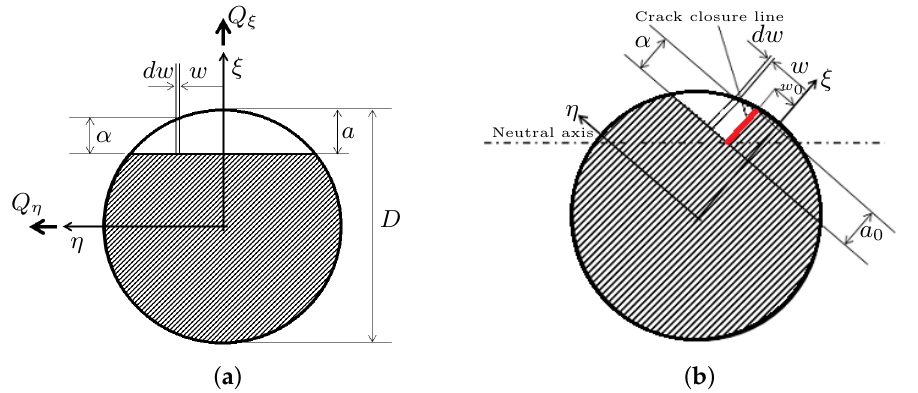
Figure 3. Crack cross-section geometry in rotating ( ζ , ξ , η ) coordinate system, ( a ) fully open